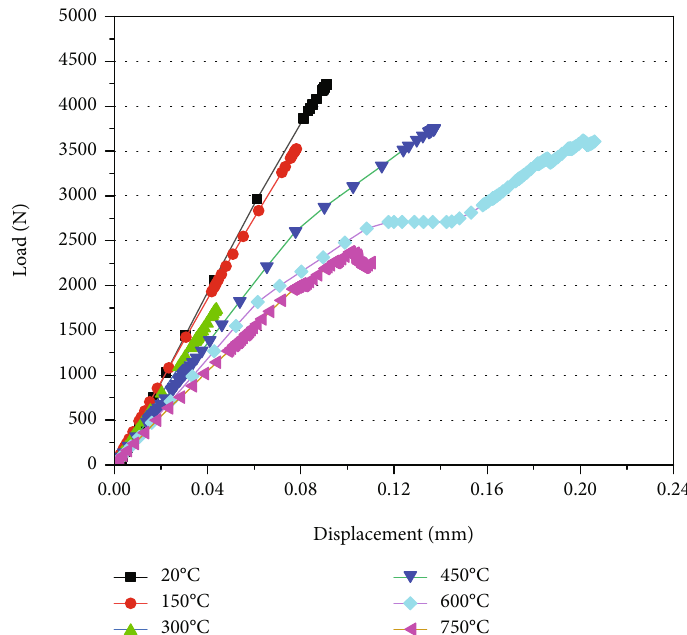
Figure 5: Load – displacement relationships for the C/SiC composite and superalloy double bolted joints under various levels of environment temperature.